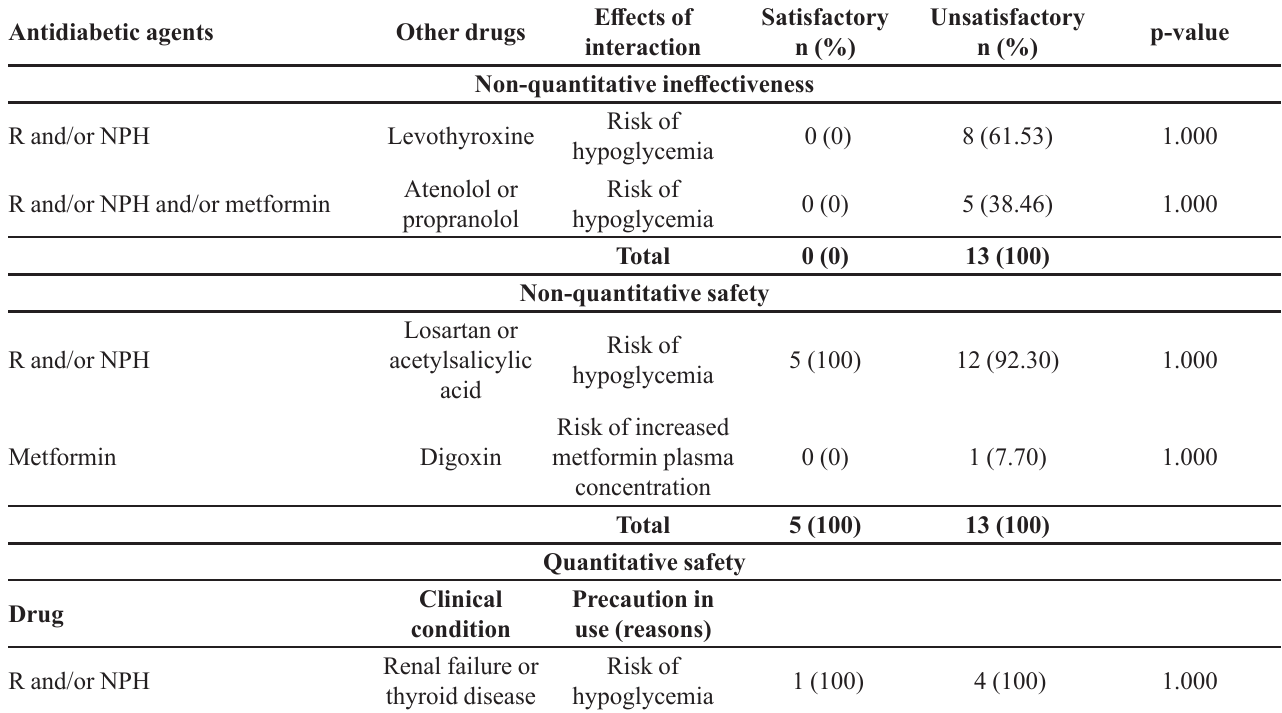
TABLE IV - Characterization of drug interactions and precautions in use associated with drug-related outcomes according to glycemic control Antidiabetic agents